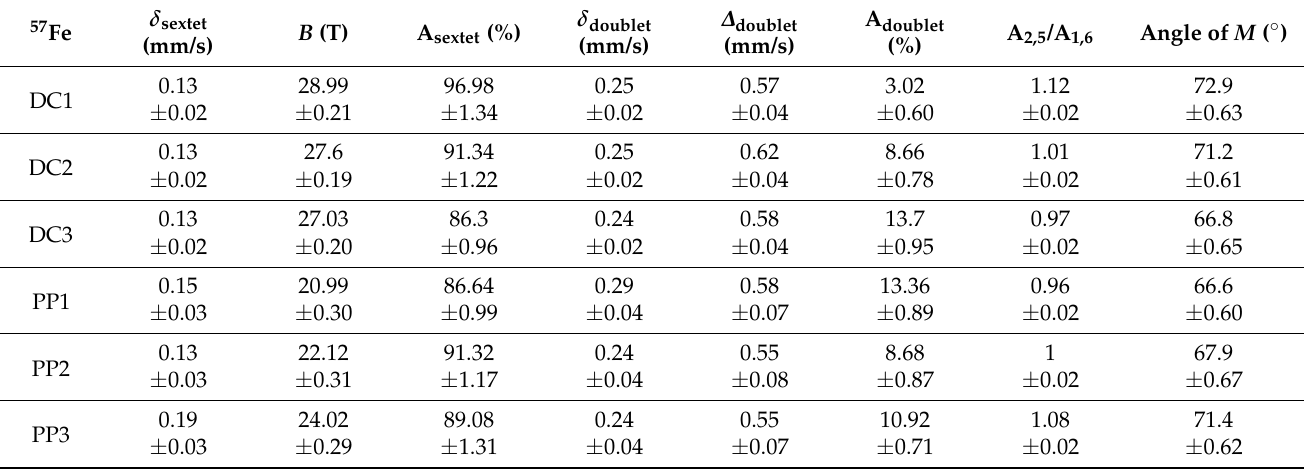
Table 3. Mössbauer parameters derived from 57 Fe CEMS of DC and PP electrodeposited quaternary Sn-Fe-Ni-Co alloys.